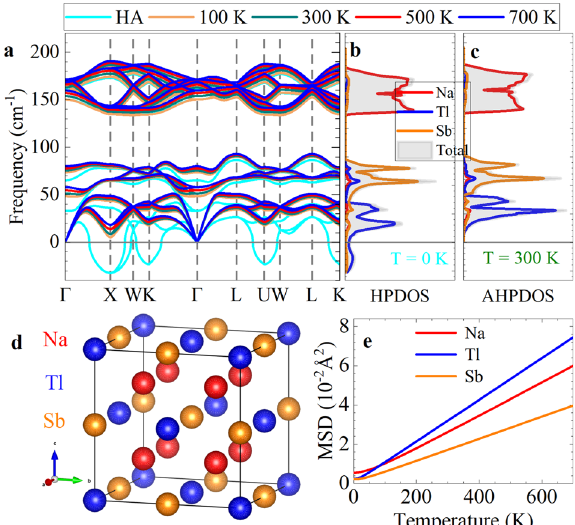
Fig. 1 Lattice vibration properties. a The temperature-dependent phonon spectrum from T = 0 to 700 K for Na 2 TlSb. The cyan line denotes the HA phonon dispersion ( T = 0 K), and the orange, dark cyan, red, and blue lines represent the SCP dispersion at 100, 300, 500, and 700 K, respectively. b , c The element-decomposed and total phonon density of states (PDOS) at T = 0 and 300 K, respectively. d The crystal structure of Na 2 TlSb, as visualized in VESTA code 62 . The red, blue, and orange balls denote Na, Tl, and Sb atoms, respectively. e The temperature-dependent atomic mean square displacements (MSDs) from 100 to 700 K along the [100] direction. The MSD from 100 to 700 K are the result of the SCP approximations.